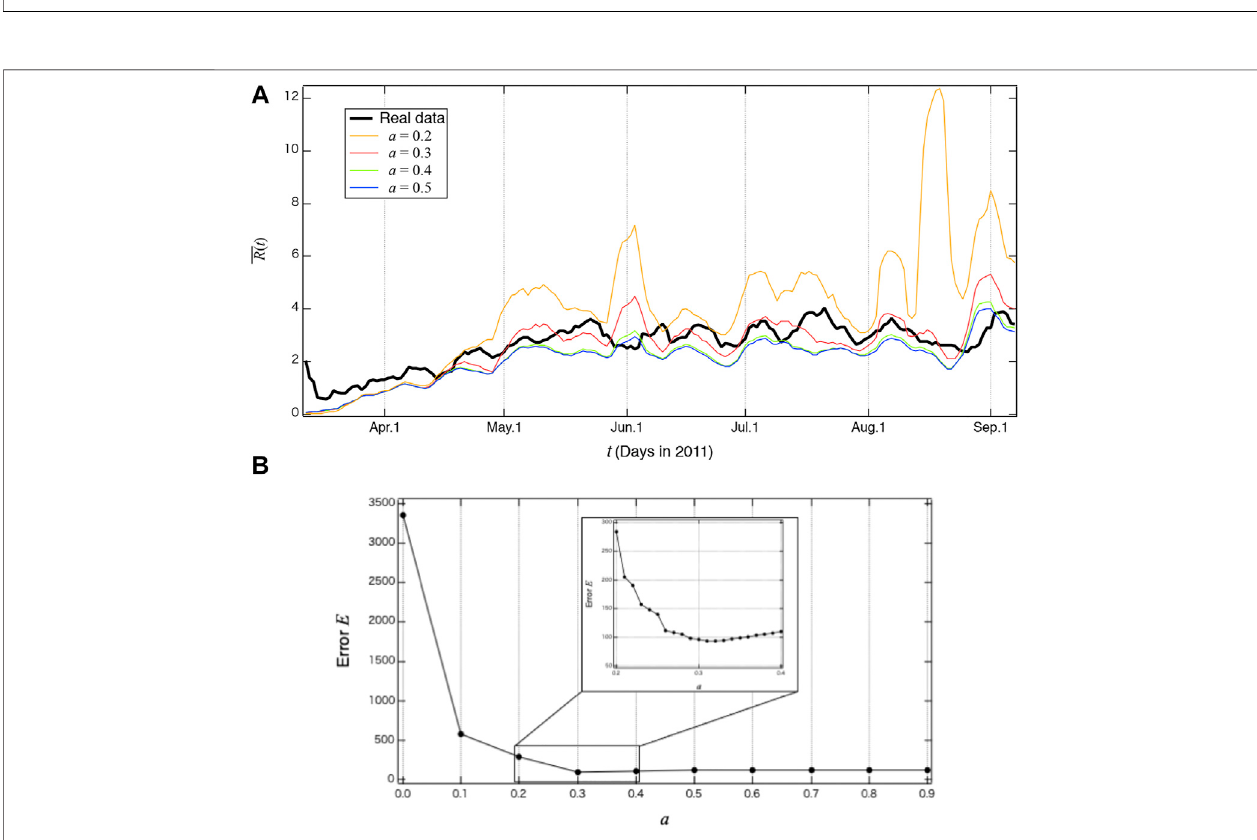
FIGURE4|(A) The7-daysmovingaverageratio R ( t ) betweenthenumberofnodesthatbelongtoGroupBdividedbythenumberofnodesthatbelongtoGroupA byoursimulation.Whentheparameterisaround a (cid:1) 0.3,itistheclosesttothereal R real ( t ) . (B) Error E betweensimulationresultandrealdatawithchangingparameter a . When a (cid:1) 0.31, error E becomes the smallest.